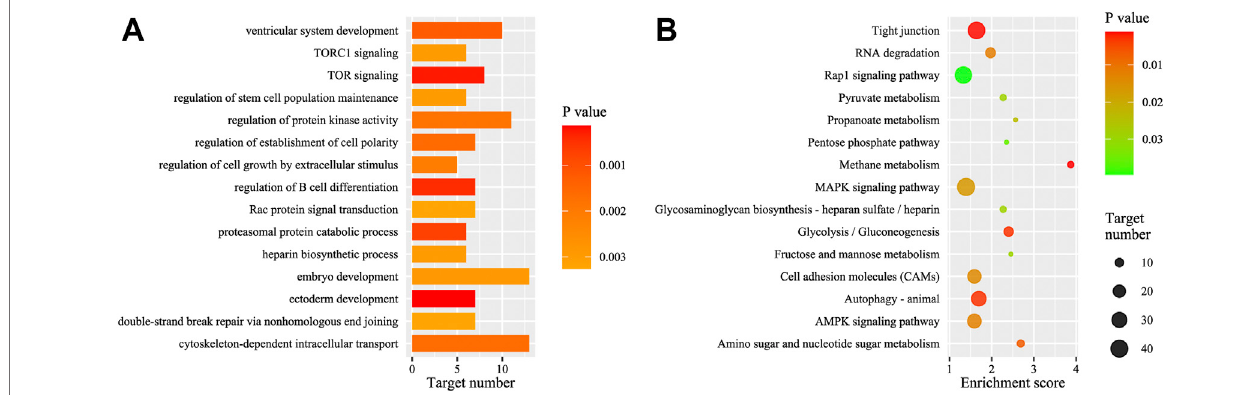
FIGURE 4 | GO and KEGG analysis of the targets of the total differentially expressed miRNAs (DEMs). (A) The top GO biology process terms; (B) the top KEGG pathways. GO, gene ontology; KEGG, Kyoto Encyclopedia of Genes and Genomes.